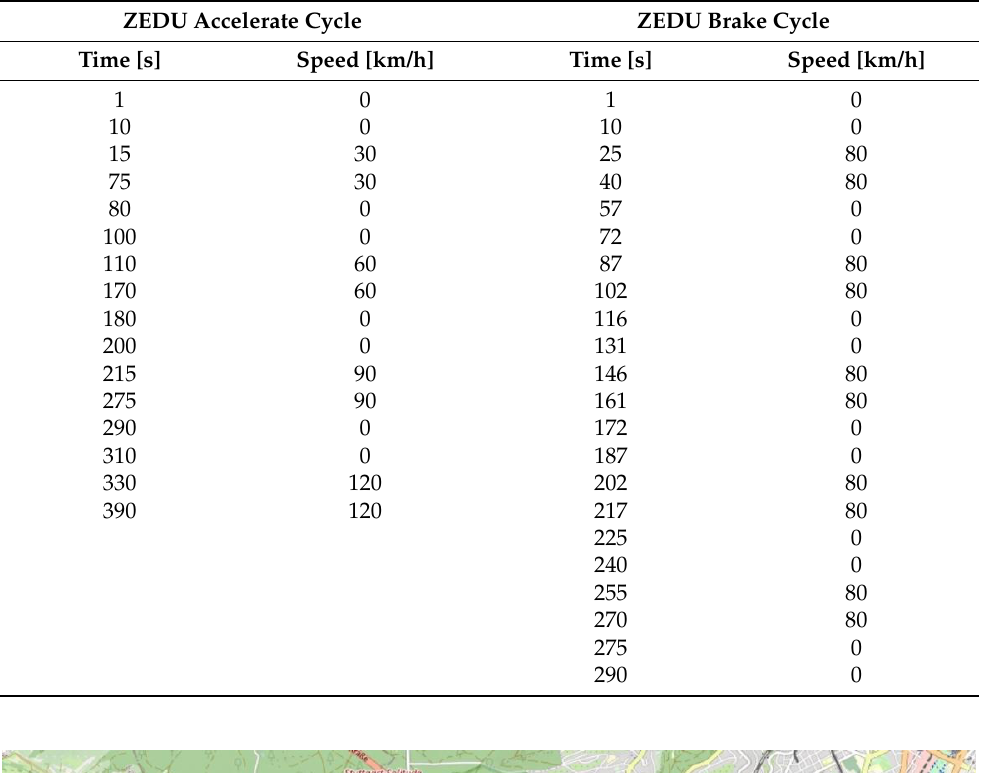
Table A1. Driving cycles for characterization of non-exhaust emissions.